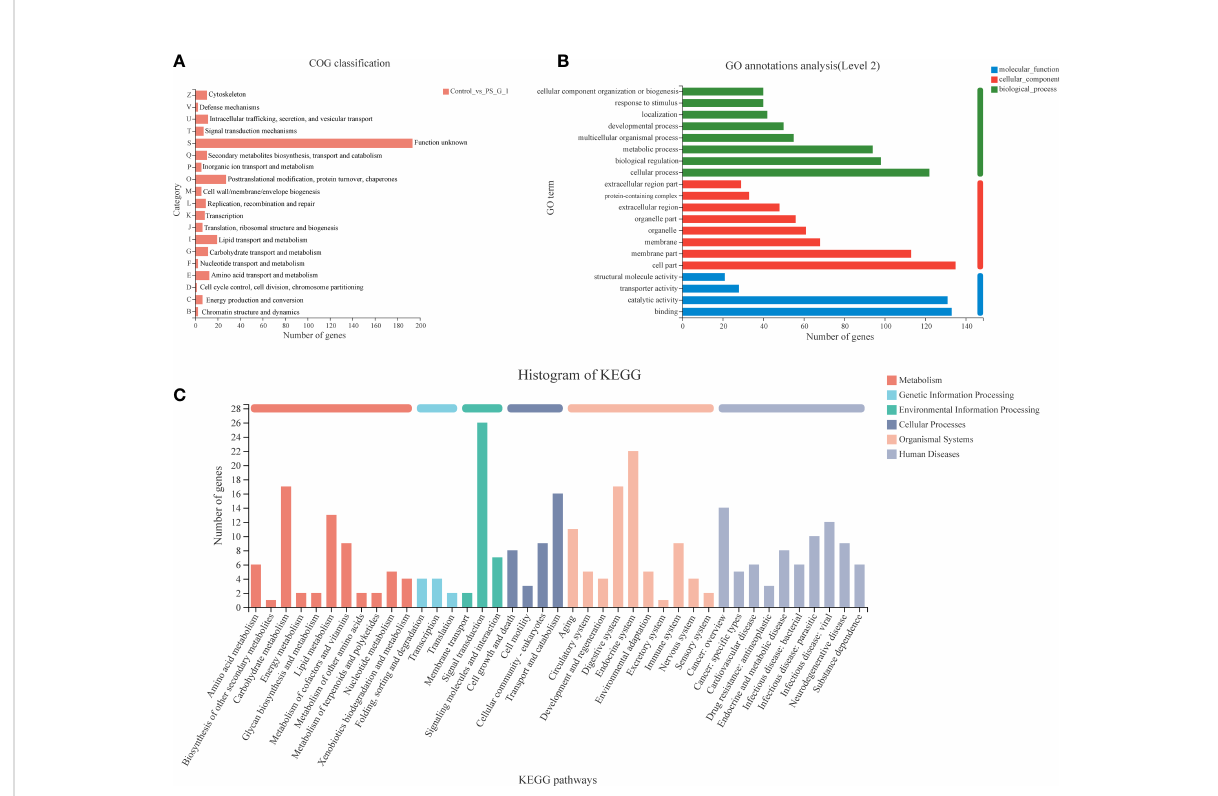
FIGURE 4 Functional classi fi cation of differentially expressed genes (DEGs) between the control and Poria cocos polysaccharides treatment groups. (A) COG, (B) GO, and (C) Kyoto Encyclopedia of Genes and Genomes annotation of